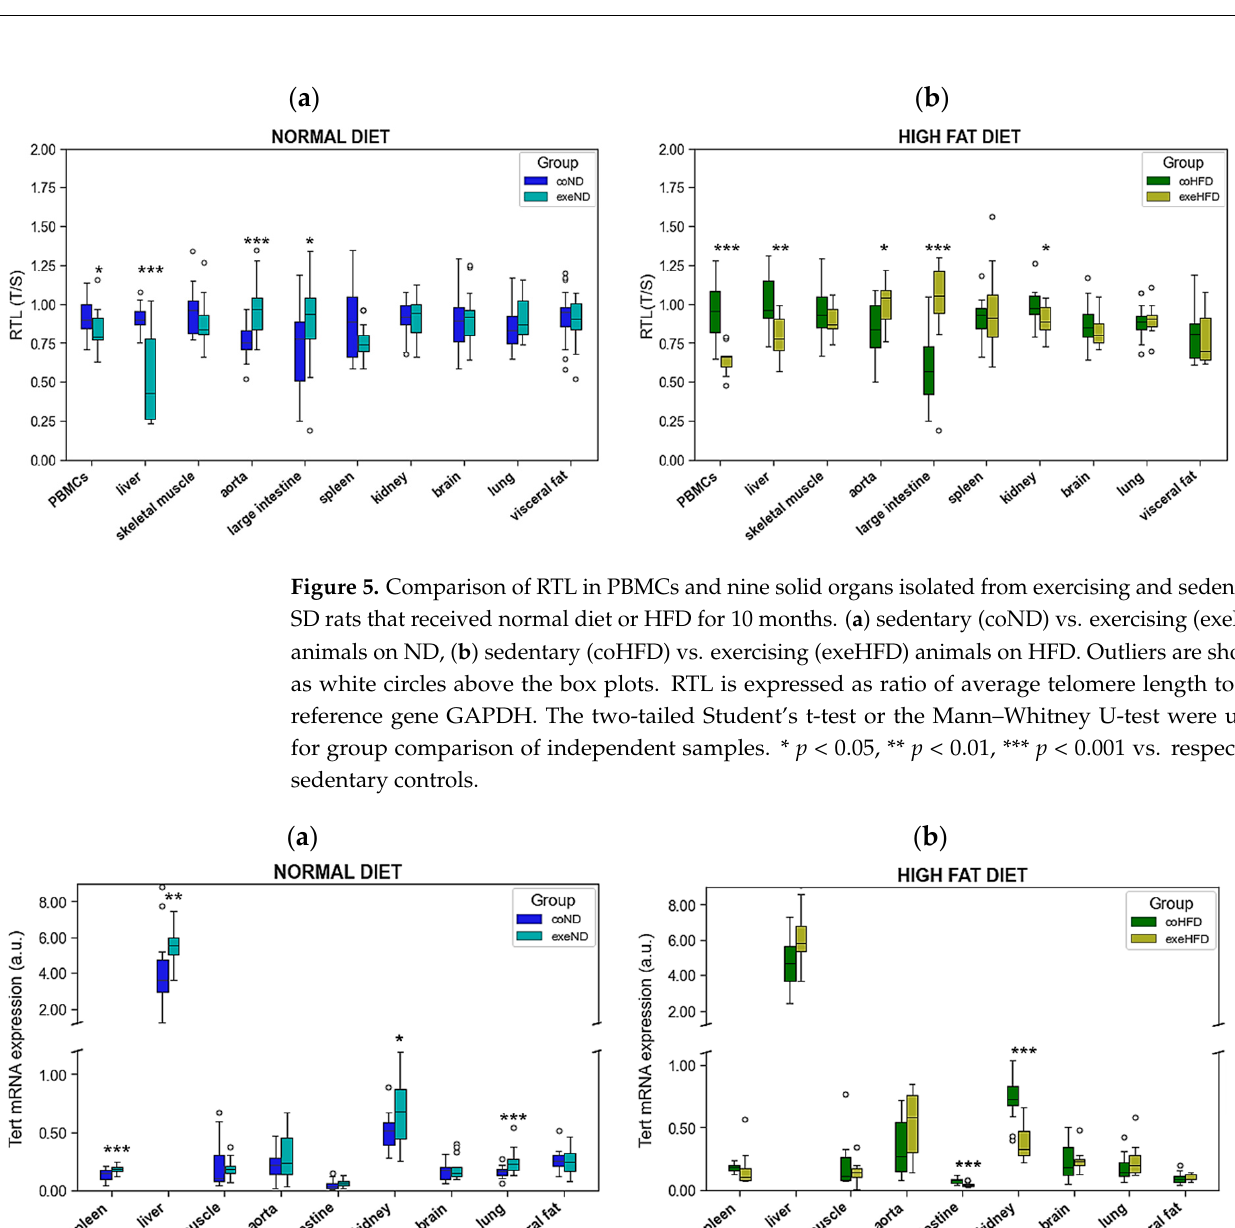
Figure 6. Comparison of TERT expression in nine solid organs from exercising and sedentary SD rats that received either normal diet or HFD for 10 months. ( a ) sedentary lean animals (coND) vs. exercising lean animals (exeND), ( b ) sedentary obese animals (coHFD) vs. exercising obese animals (exeHFD). Outliers are shown as white circles above the box plots. TERT mRNA expression is shown in arbitrary units. The two-tailed Student’s t -test or the Mann–Whitney U-test were used for group comparison of independent samples. * p < 0.05; ** p < 0.01; *** p < 0.001 vs. respective sedentary controls.